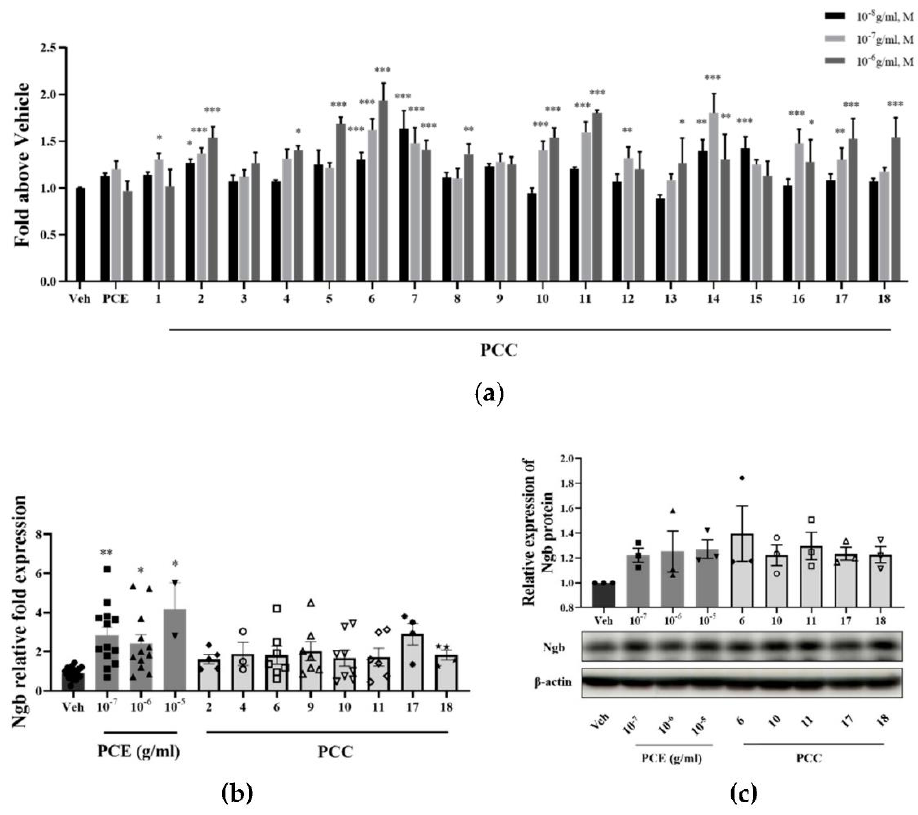
Figure 1. PCE and PCCs induce Ngb transcriptional activity and increase Ngb protein levels in treated neuronal cells. ( a ) Increased Ngb promoter activity levels from PCE and PCCs by luciferase reporter assay in SKNSH cells. SKNSH cells were treated with various concentrations of PCE (10 − 8 − 10 − 6 g/mL, n = 10) and PCCs (10 − 8 − 10 − 6 M, n = 10) for 1 day. Results are expressed as the relative luciferase value (Veh, n = 20). ( b ) Levels of Ngb mRNA were increased by PCE (10 − 7 − 10 − 5 g/mL) and PCCs (10 − 6 M) in SKNSH cells. The ratio of target gene expression to that of GAPDH housekeeping gene was determined by qPCR as a quantitative measure of gene expression. Ngb mRNA levels were significantly increased by 10 − 5 g/mL PCE and leucoside (Veh, n = 18; PCE, n = 13; PCCs, n = 8). ( c ) Protein levels of Ngb were induced by PCE (10 − 7 − 10 − 5 g/mL) and selected PCCs (10 − 6 M) in primary neuronal cells ( n = 4). The mean values in triplicate experiments are presented as SEM. *** p < 0.001, ** p < 0.01, * p < 0.05 compared with the vehicle control,